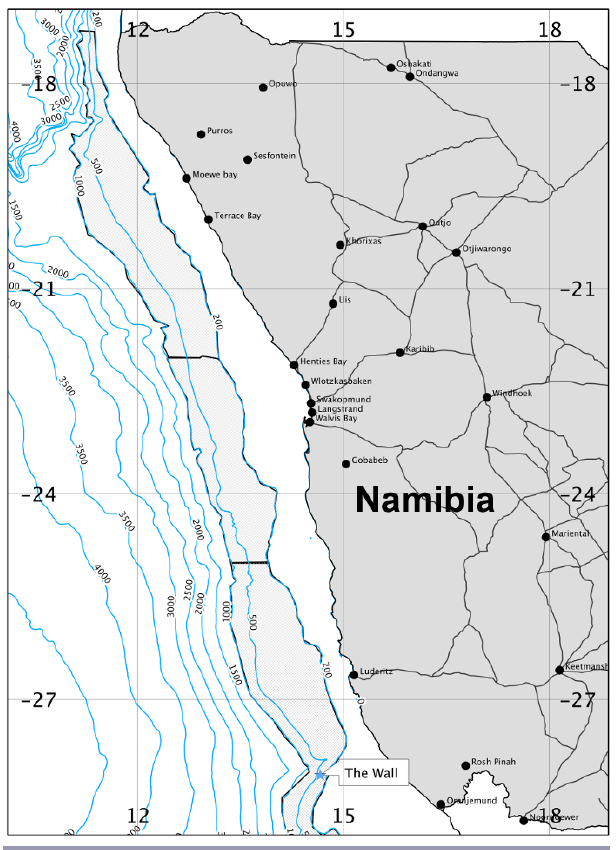
Fig. 2 . Map of the Namibian fishing area for hake; fishing takes place along the entire coast and concentrates at depths of 200 to 400